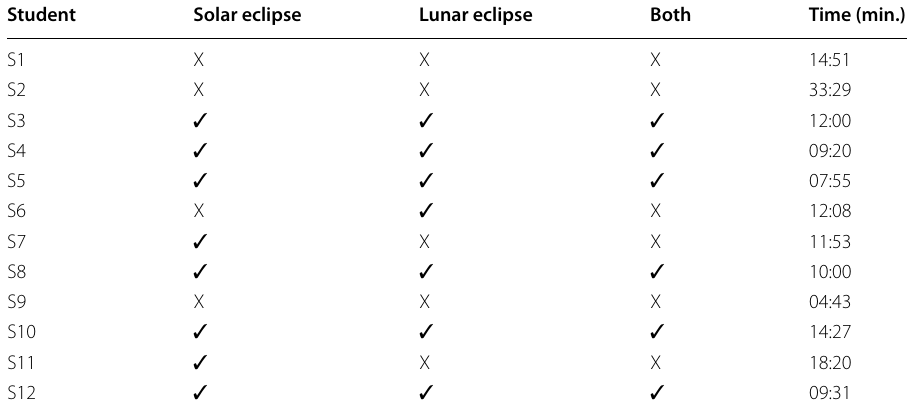
Table 1 Fully correct completions status and time (minute)